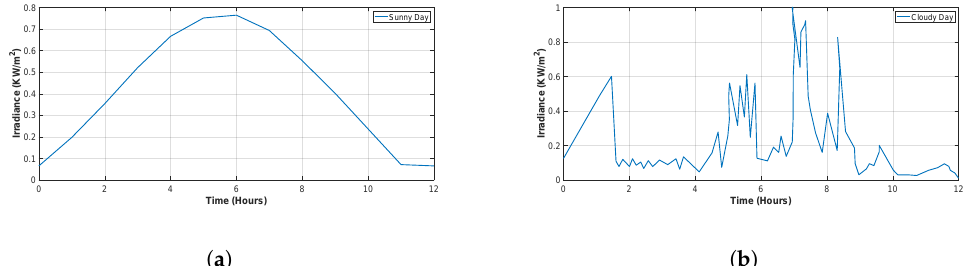
Figure 6. ( a ) Sunny Day Irradiance Data from 6 a.m. to 6 p.m. ( b ) Cloudy Day Irradiance Data from 6 a.m. to 6 p.m.